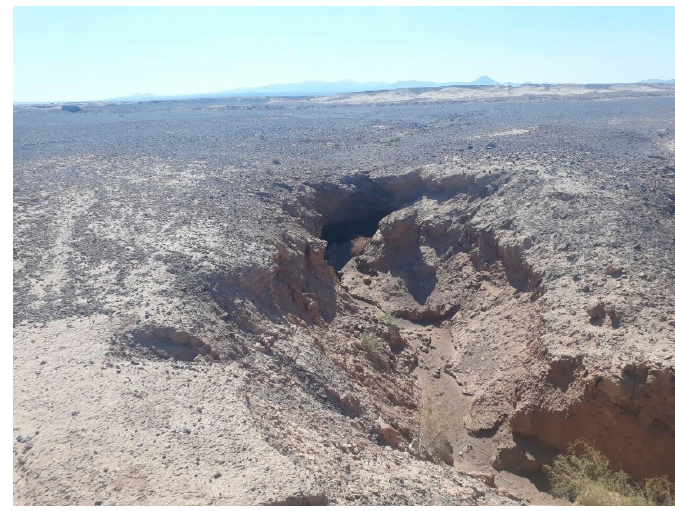
Figure 3. Head-cut of some of the mapped gullies in the study area.